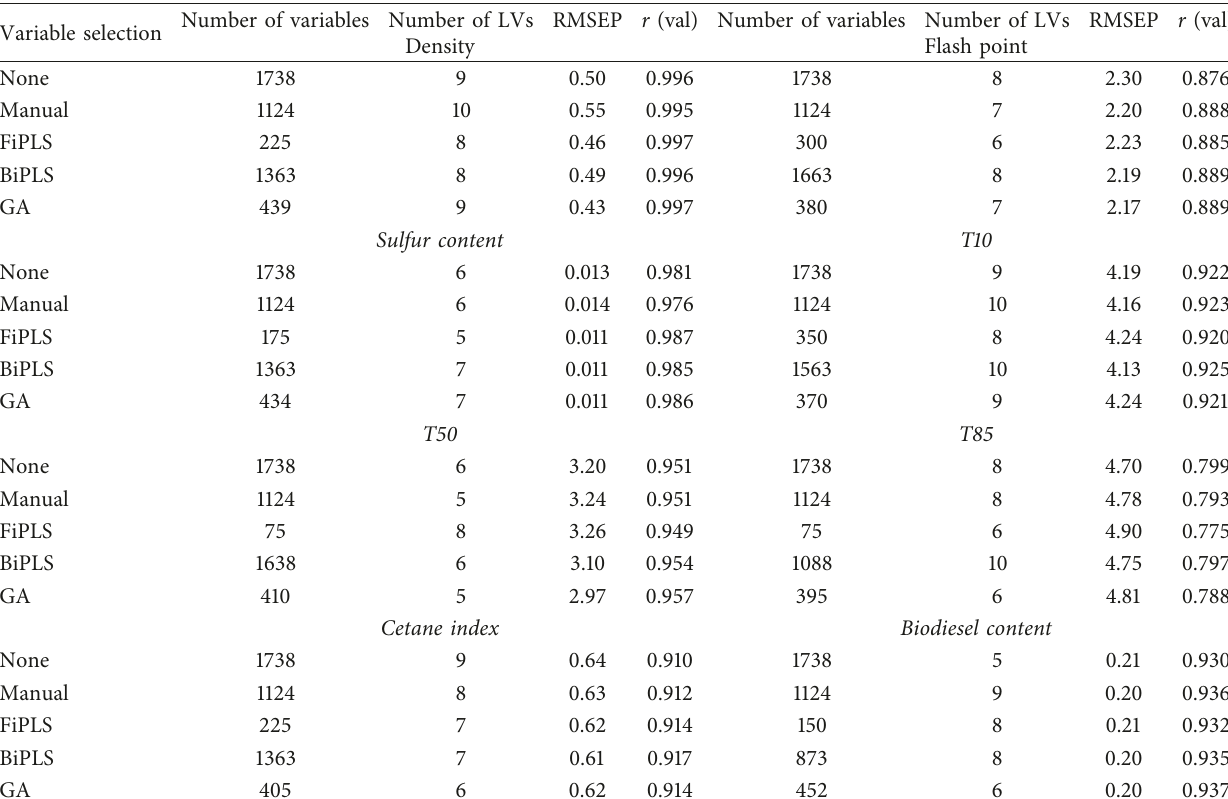
Figure 2: The mean spectrum (red line) and relative standard deviation (blue line) of 14 replicates of a diesel Table 6: PLS models using different variable selection approaches.